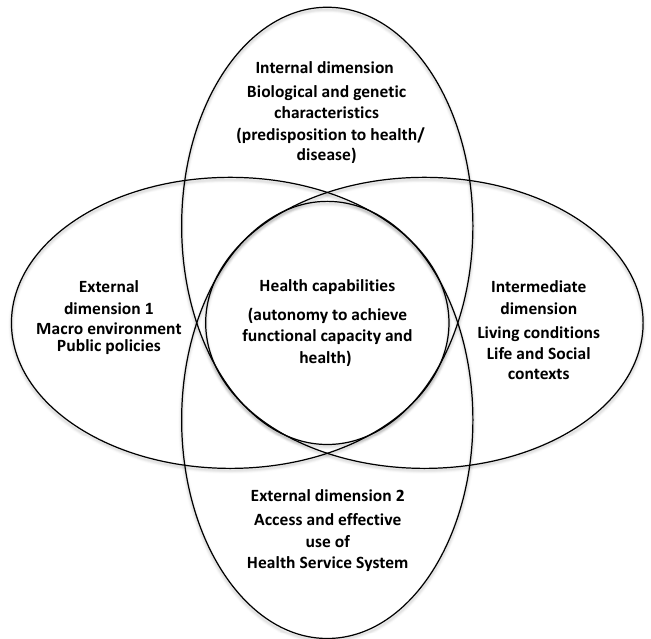
Figure 2. Adapted from Conceptual Model of Health Capability (CMHC–Ruger, 2010)